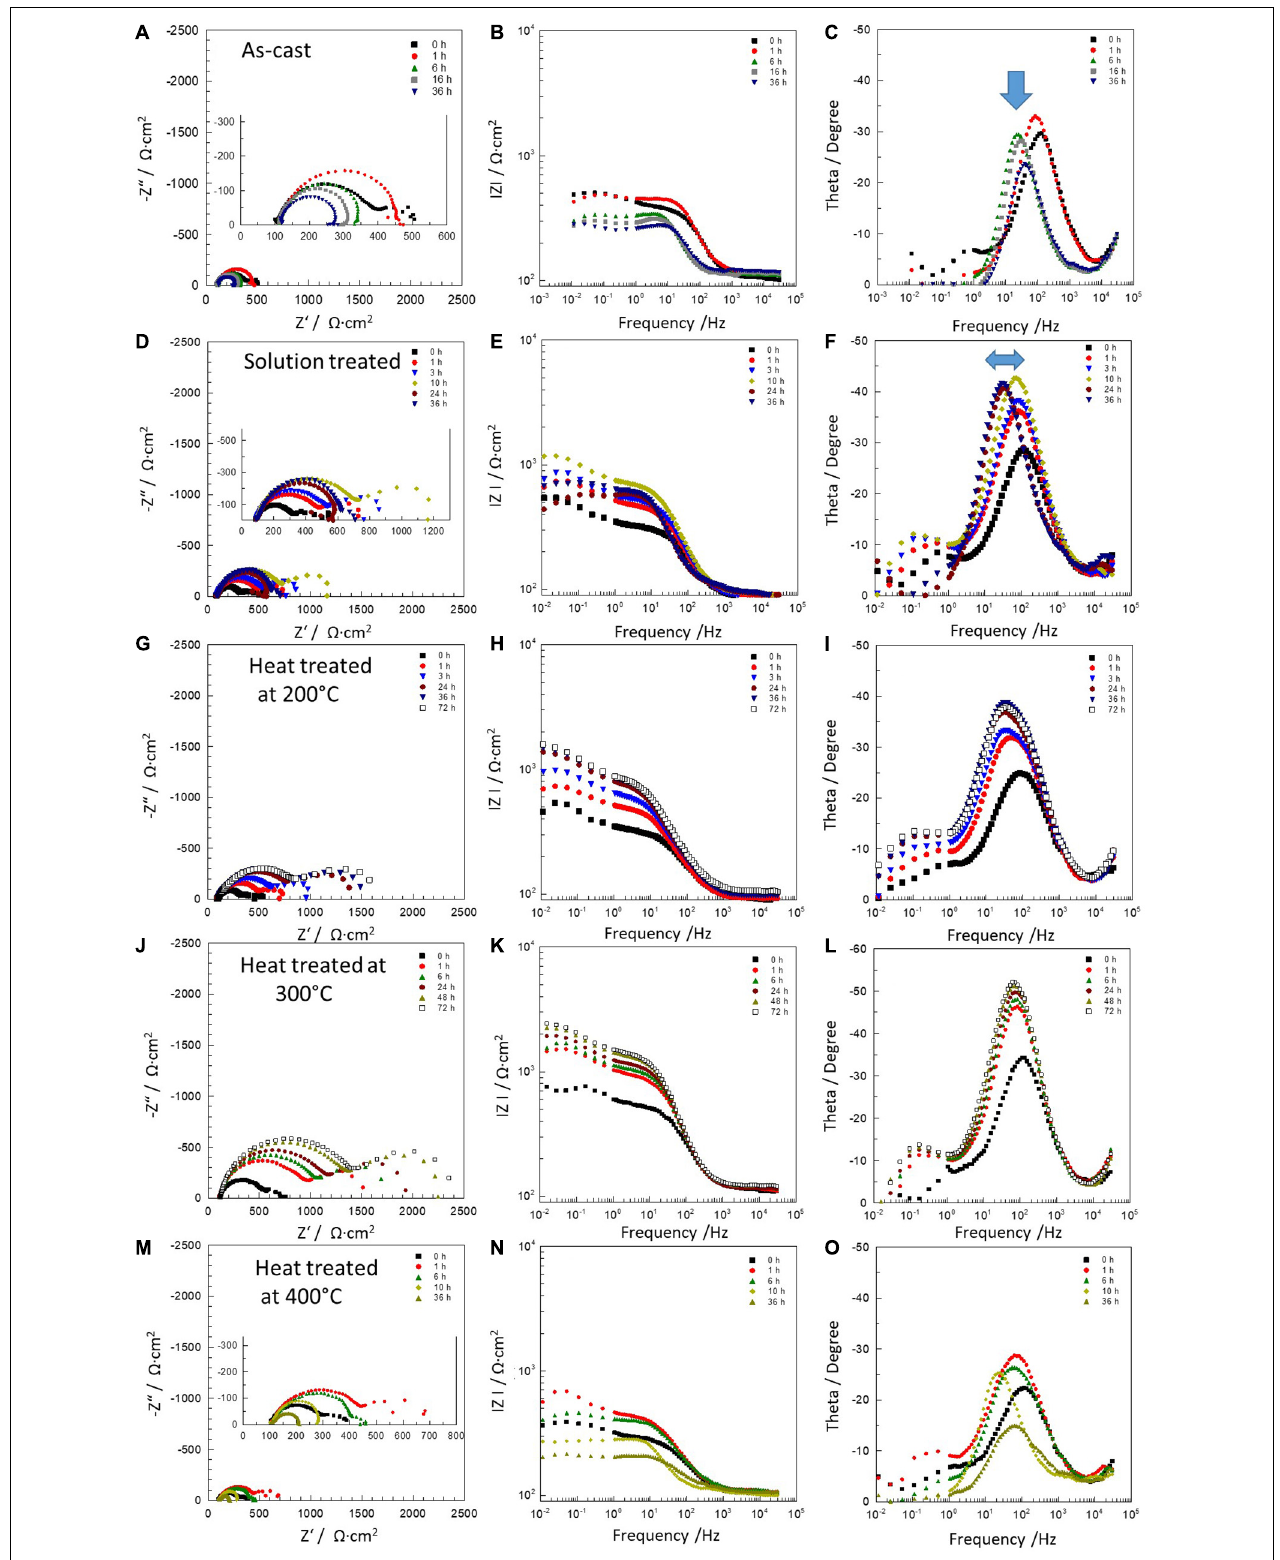
FIGURE 6 | Electrochemical impedance spectra of Mg-10Gd alloys: as-cast (A–C) , solution treated (D–F) and heat treated at 200 ◦ C (G–I) , 300 ◦ C (J–L) and 400 ◦ C (M–O) . Where the blue arrow indicates the displacement of the time constant from high frequencies to middle frequencies.